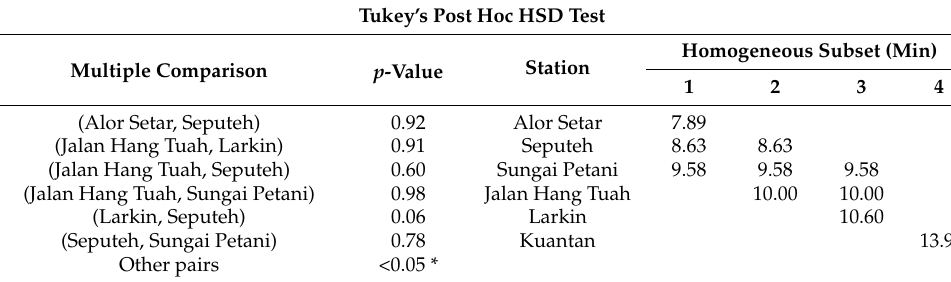
Table 5. Summary of Tukey’s post hoc HSD test for mean response time between category A fire